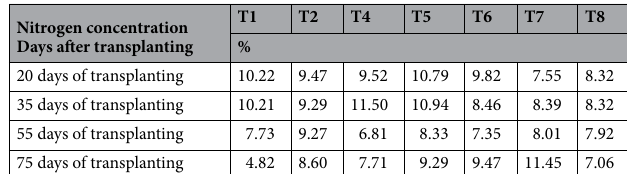
Nitrogen concentration Days after transplanting